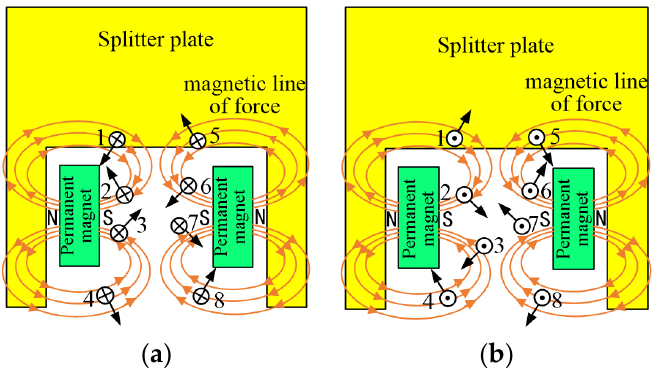
Figure 2. Arrangement schematic diagram of permanent magnet. ( a ) The current goes into the paper. ( b ) The current goes out of the